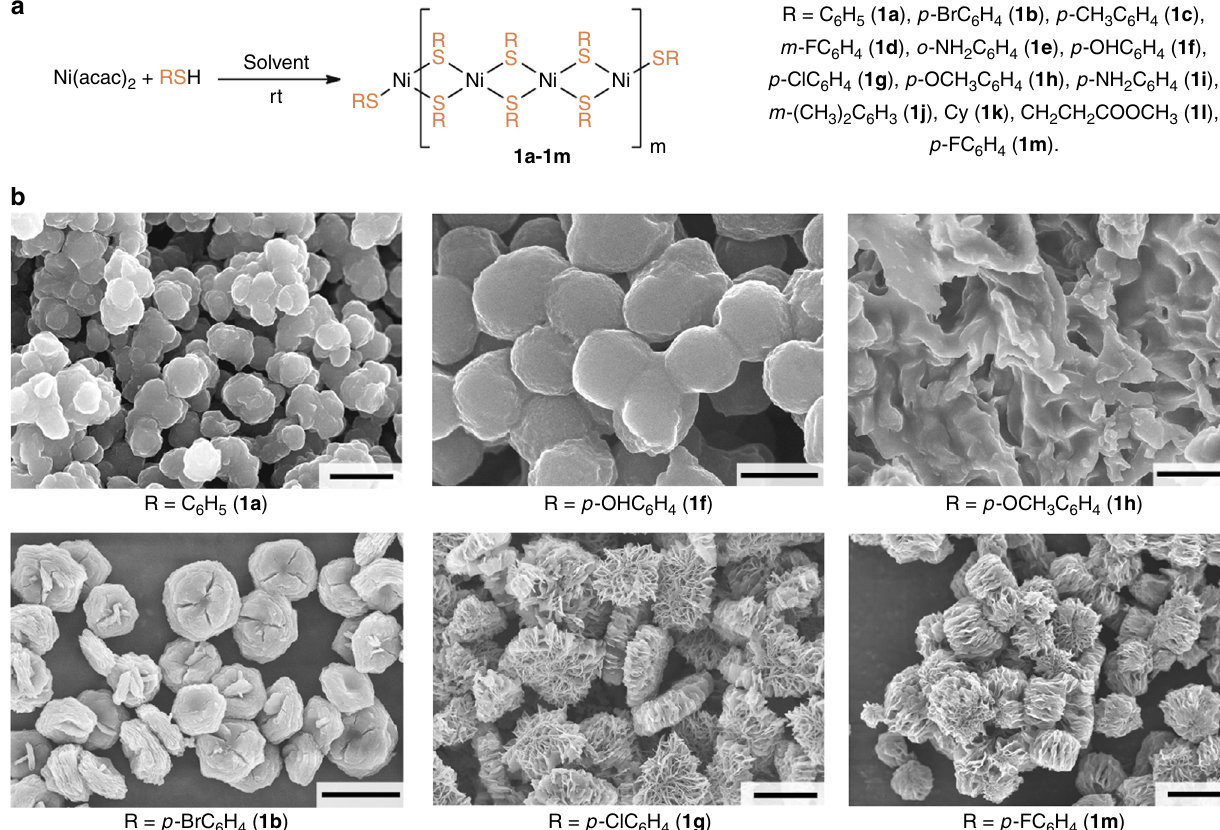
Fig. 2 Synthesis and characterization of nickel thiolates. Scheme of reaction between Ni(acac) 2 and thiols ( a ) and FE-SEM images for selected nickel thiolates with different types of morphology ( b ). Scale bars – 500 nm for 1f , 1 μ m for 1a , 5 μ m for 1b and 1h , 10 μ m for 1g and